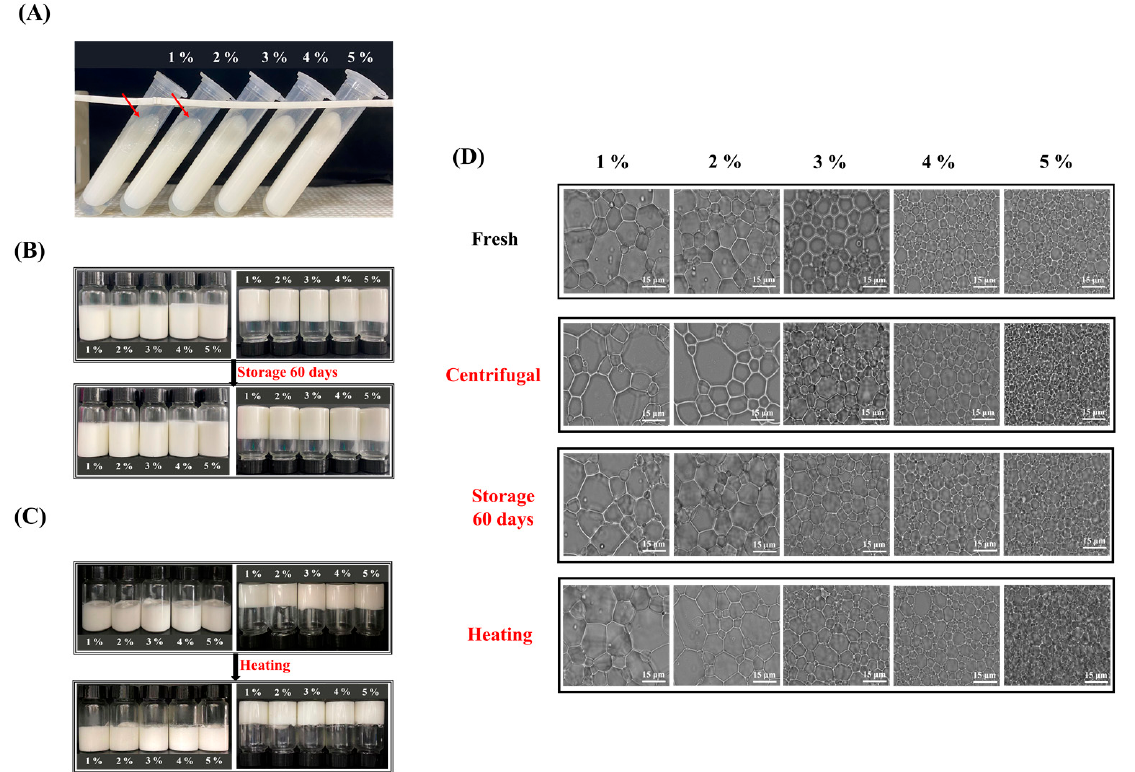
Figure 7. Appearance of HIPEs stabilized by 1–5 wt% MPPI after ( A ) centrifugation, ( B ) storage, and ( C ) heat treatment. ( D ) Optical microscope of HIPEs stabilized by 1–5 wt% MPPI before and after centrifugation, storage, and heat treatment.